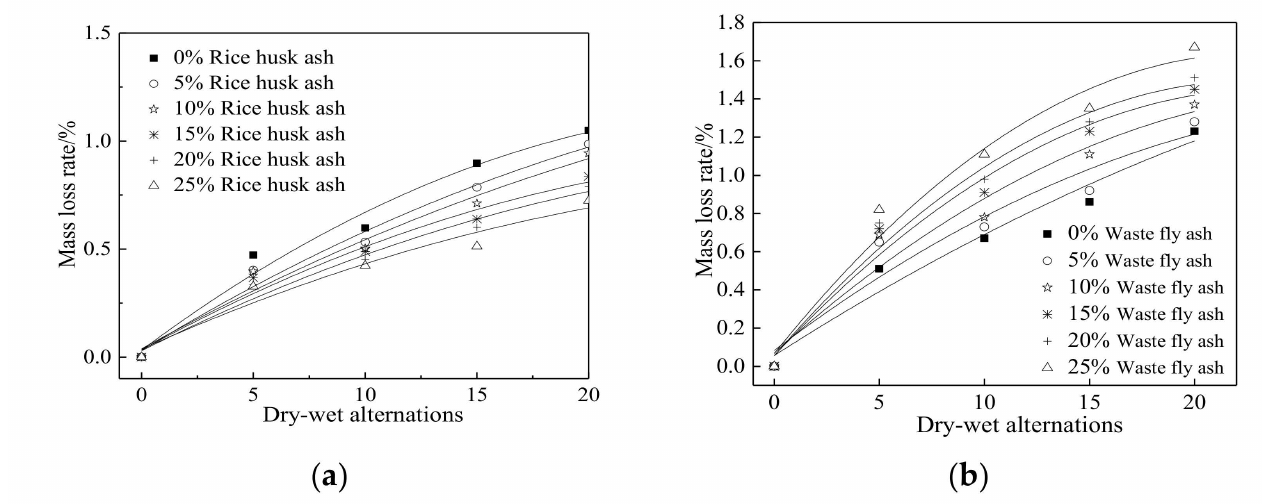
Figure 9. The mass loss rate of RPC during NaCl dry–wet alternations. ( a ) The mass loss of RPC with rice husk ash. ( b ) The mass loss of RPC with waste fly